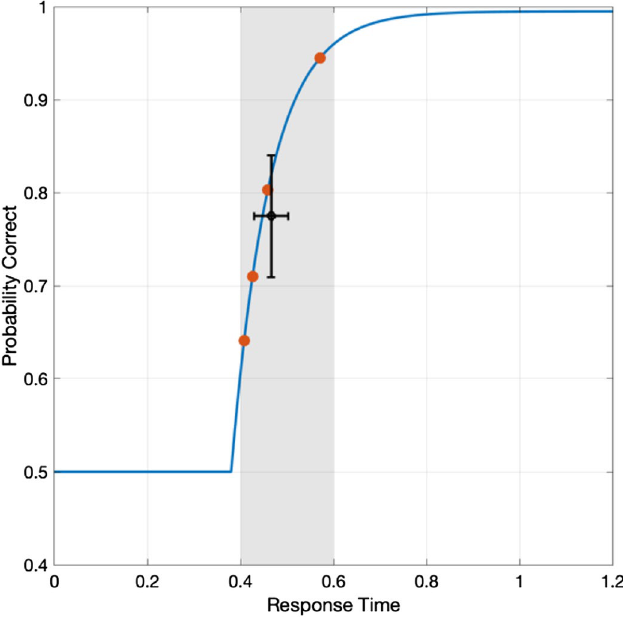
Figure 7. Illustration of a large variability problem. In a block of SOA = 0.4 s, RTs (red dots) are a random variable between 0.4 and 0.6 s (shaded area), and the mean RT has variability (horizontal error bar). The corresponding accuracy for the RTs also has large variability (vertical error bar) and measurement